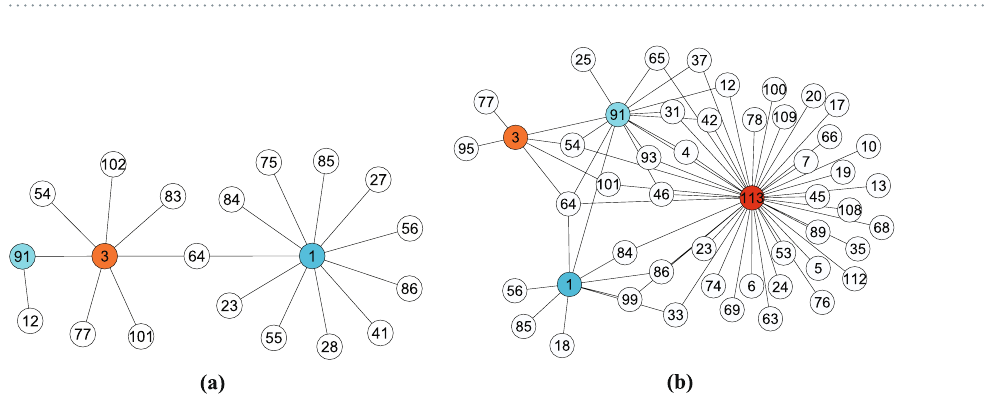
Figure 4. Predicted connections of large-degree node 1, 3 and active node 91, 113 in Hypertext. Only the selected nodes and their neighbors are plotted, and the connections are the subset of the top- E P predicted links. Panel (a) shows the connections predicted by SPM. Node 1 and 3 are much more attractive than node 91, and node 113 is not presented because of no connections. Panel (b) shows the connections predicted by PBSPM. The active node 91 and 113 attract numerous nodes, which gives rise to the explosive growth of edges.